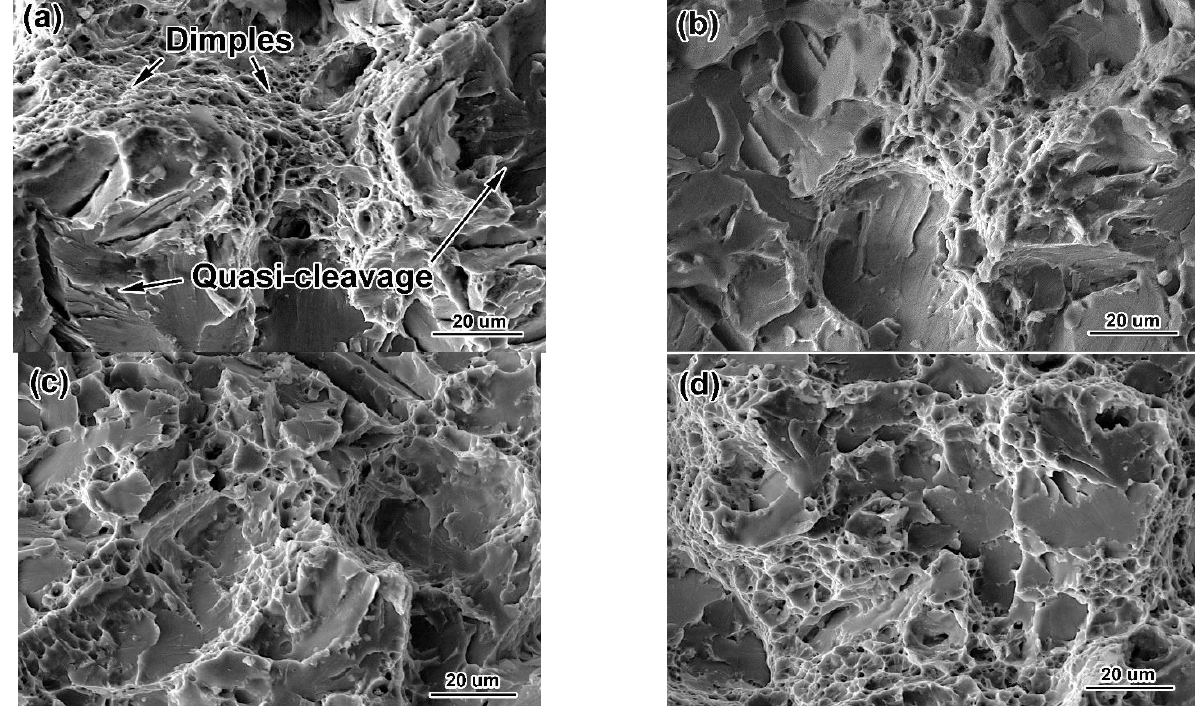
Figure 9. The fracture patterns of the V-notched specimens austenitized at ( a ) 770 °C, ( b ) 830 °C, ( c ) 900 °C, and ( d ) 950